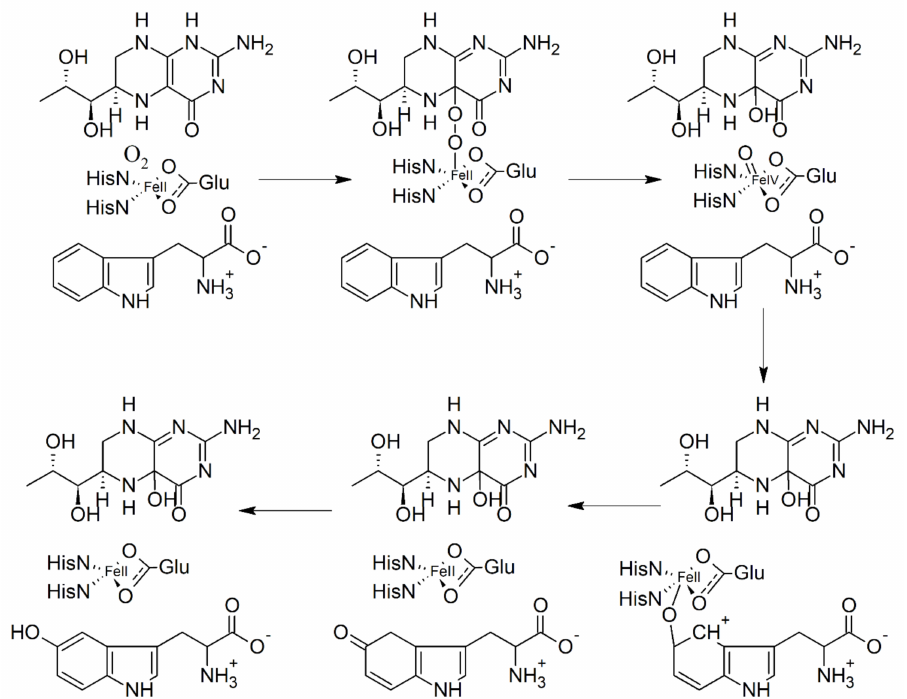
Figure 2. Hydroxylation of tryptophan by tryptophan hydroxylase (TPH). See text for explanation. From [58], modified.